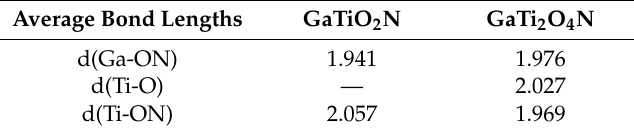
Table A3. Average bond lengths of the predicted Ga-Ti-O-N structures optimized at 20 GPa.